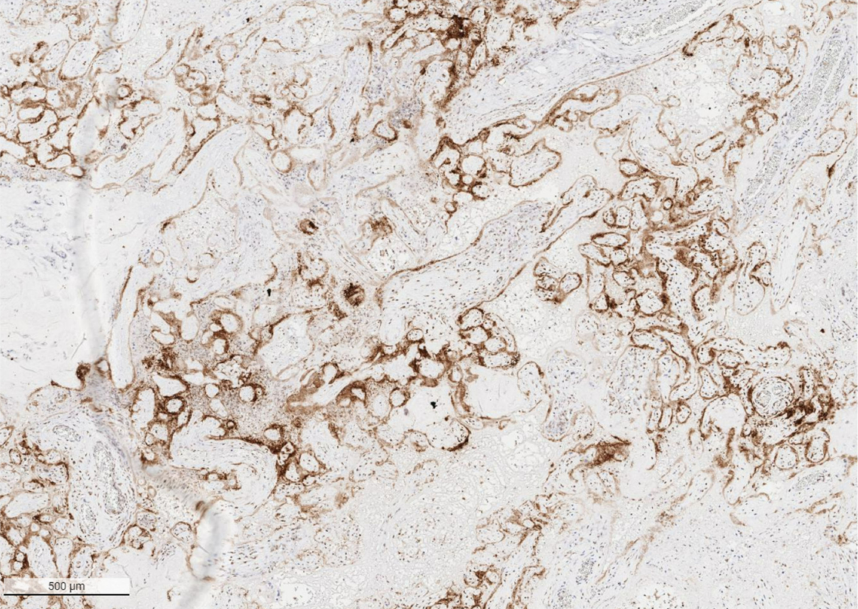
Figure 1. Low power image of placenta with SARS-CoV-2 placentitis from a stillborn fetus showing the pattern of positive staining of the villous syncytiotrophoblast for SARS-CoV-2 antigen. Antibody to SARS-CoV-2 spike protein, × 4.